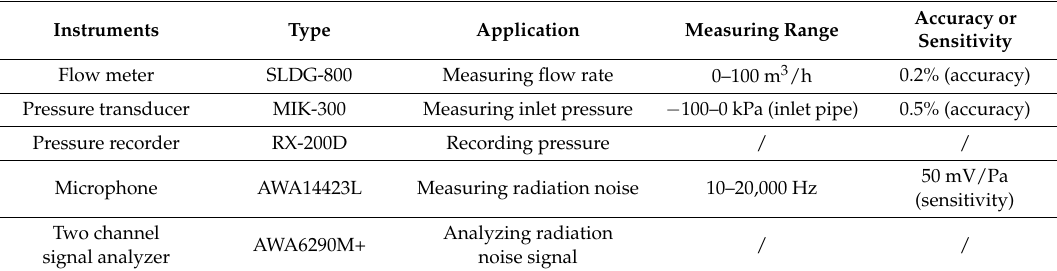
Table 2. Measurement characteristics of instruments.